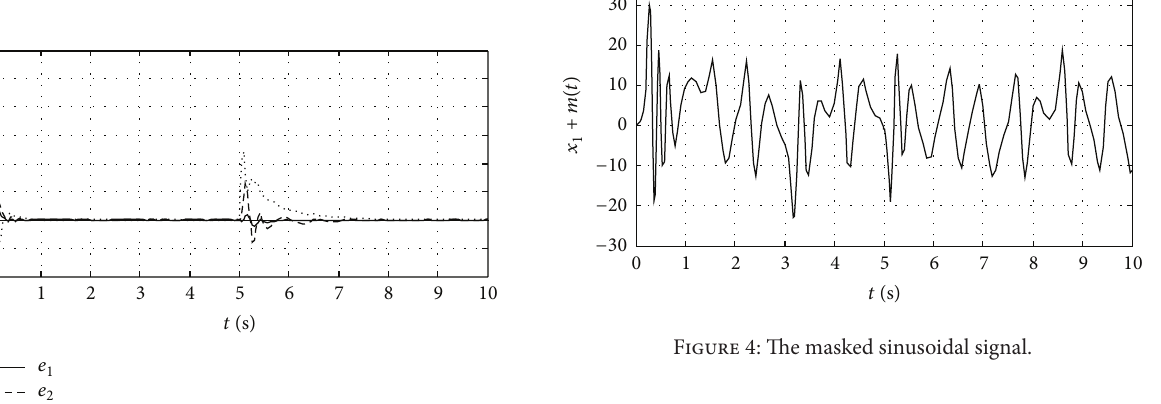
Figure 1: The trajectories of a fault (solid line) and the fault estimation (dotted line).